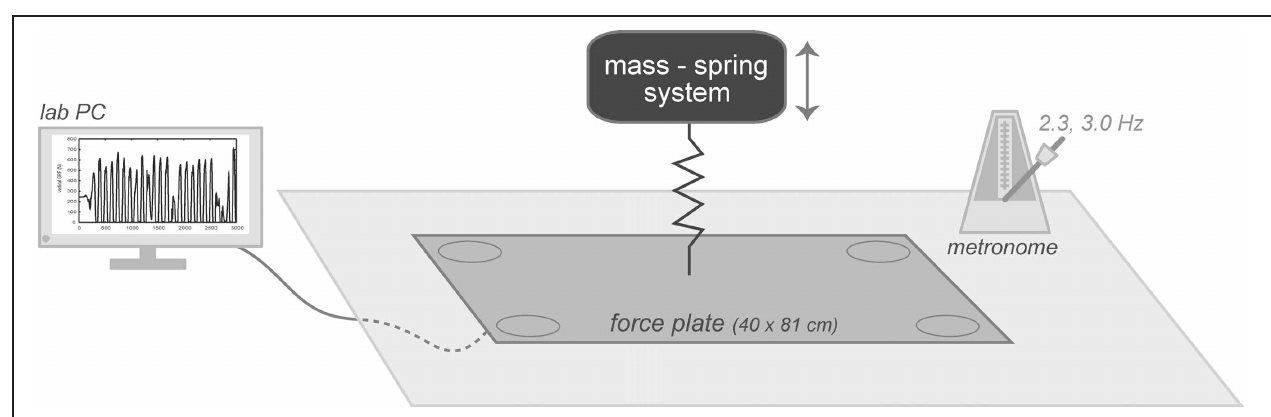
FIGURE 2 | Subjects were positioned on a 40 × 81cm embedded force plate, a metronome was set at either 2.3 or 3.0Hz, and a lab computer collected vertical ground reaction forces. The system was modeled as a mass-spring system where effective leg stiffness was calculated for each trial.